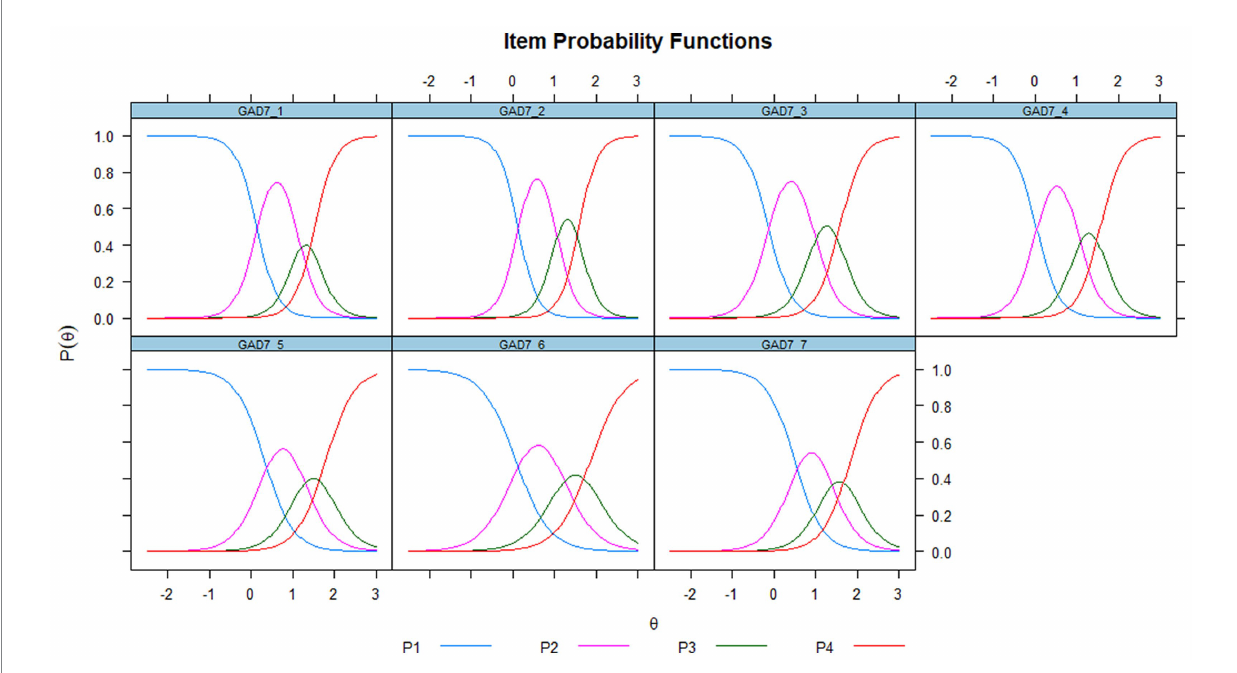
FIGURE 2 Item characteristic curves (item probability functions). P1, P2, P3, P4: response options “not at all,” “several days,” “more than half the days,” “nearly everyday,”